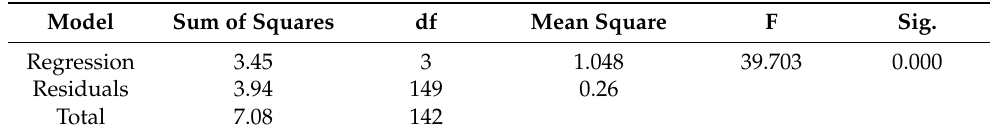
Table 4. Results of the ANOVA analysis of the MLR